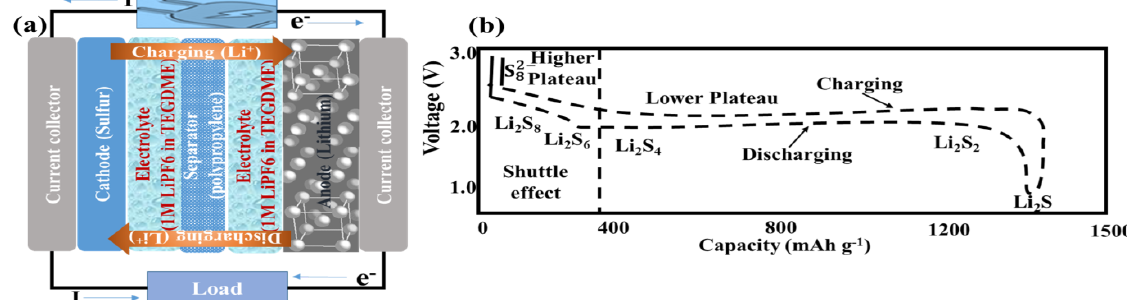
Figure 1. ( a ) The schematic view of a lithium-sulfur battery with all its components in discharging (Load) and charging (Electric plug) conditions, and ( b ) charging/discharging conditions with different Li x S y complexes, together with the shuttle effect region .